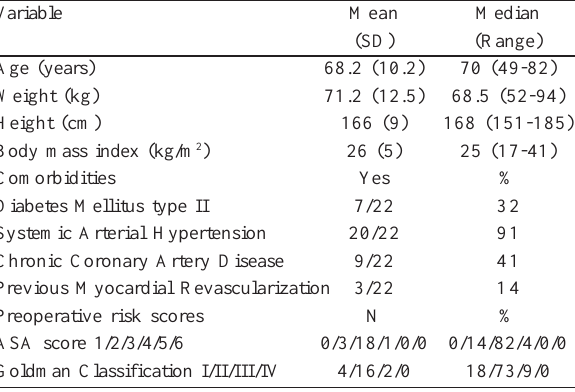
Table 1. Basal characteristics of the study population (n = 22) Variable